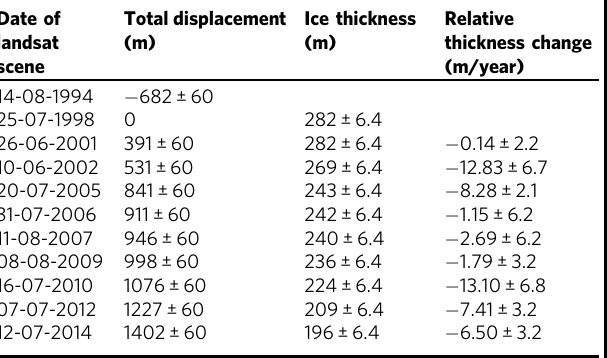
Table 1 Midgardsormen grounding line